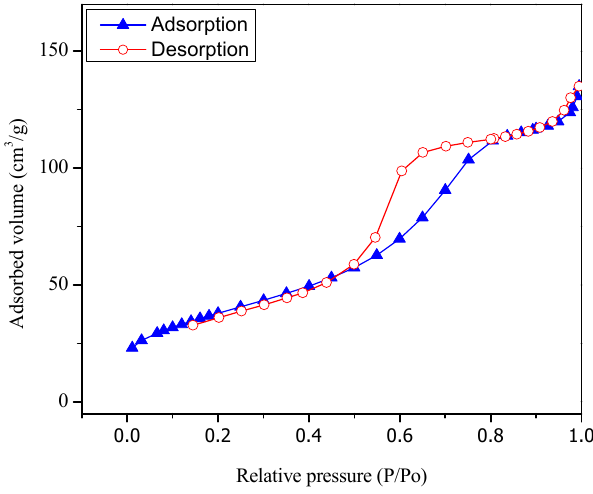
Figure 4. Adsorption–desorption of N 2 on TiO 2 with 1.70 wt. % Pt prepared via the sol-gel A method.